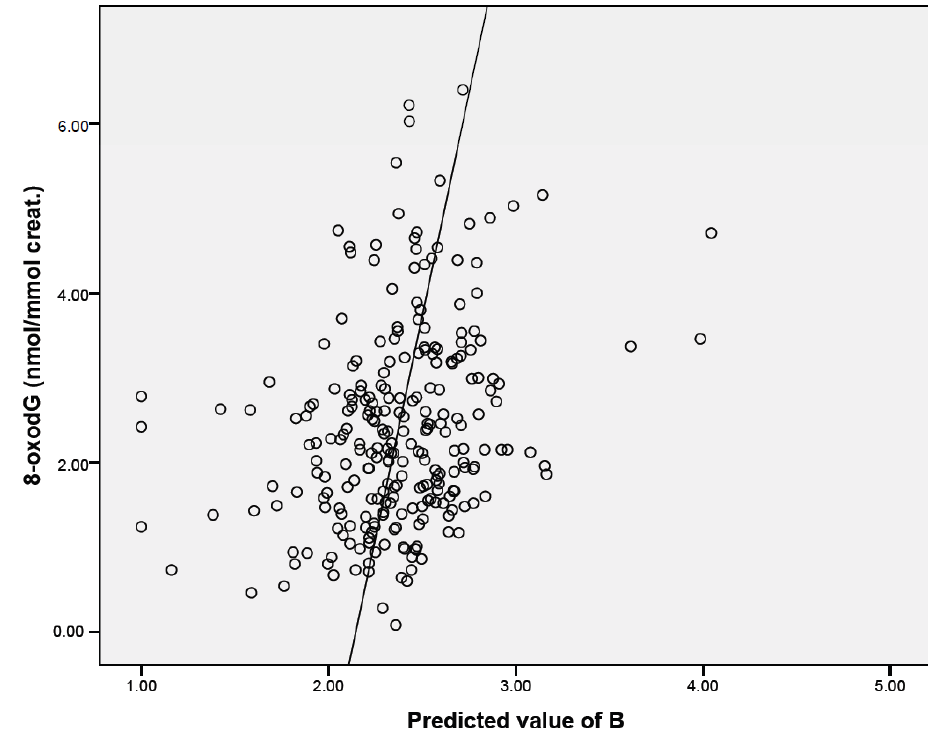
Figure 1. Graphical visualization of multivariate-adjusted association between 8oxodG levels and parameters reported in Table 5.